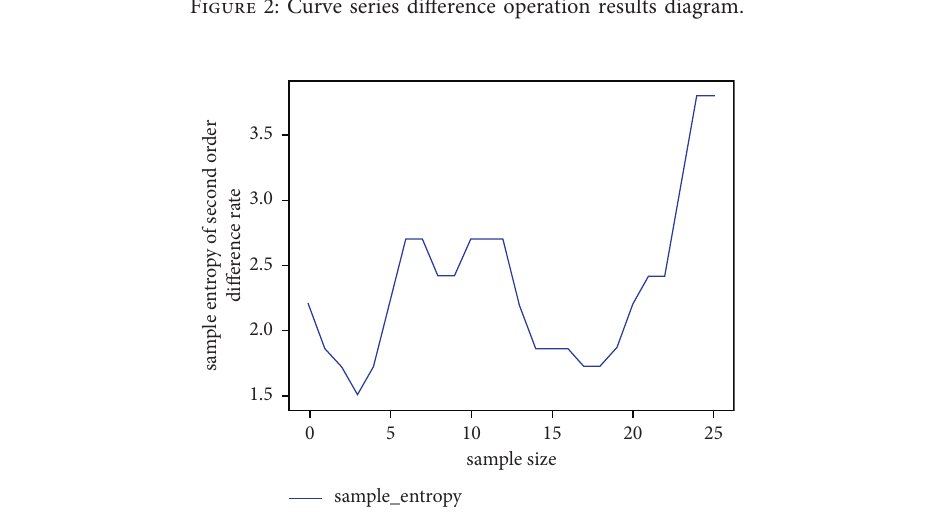
Figure 3: Second-order difference rate sample entropy feature series diagram.